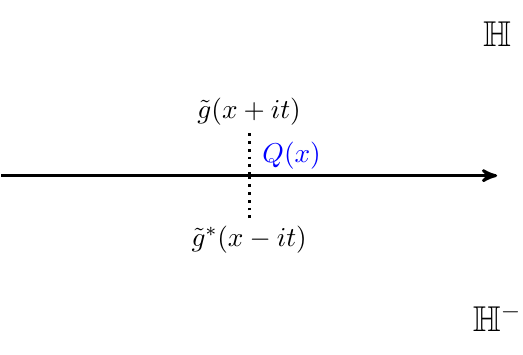
Figure 8 . The upper- and lower-half planes and quantum modular